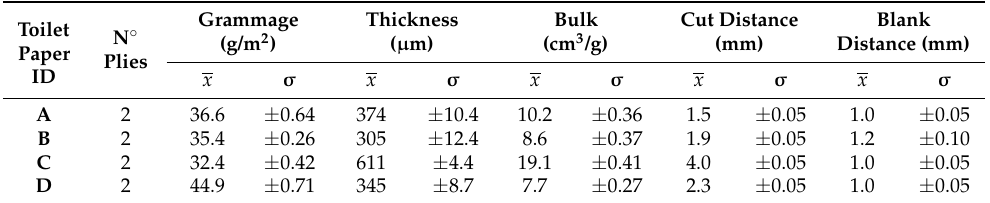
Table 1. Physical characterization of the toilet papers: number of plies, grammage, thickness, bulk, cut and blank distance.